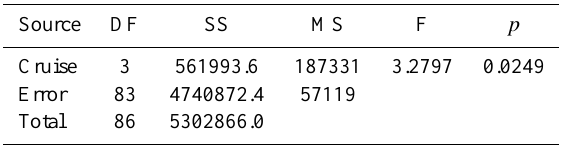
Table 2. ANOVA comparing areal rates of N 2 fixation by Tri- chodesmium measured on different cruises (SJ9603, SJ9612, MP01, and MP03) within the region defined by 0 ◦ < latitude < 15 ◦ N and